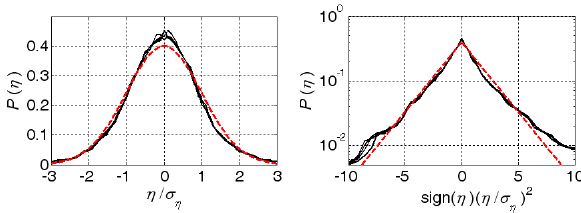
Fig. 5. Probability density function of the incident wave field in linear and semi-logarithmic scales. Solid lines show the statistics for experiments with Br σ = 0.2, 0.25, 0.27, and 0.3. Dashed line corresponds to the normal distribution.